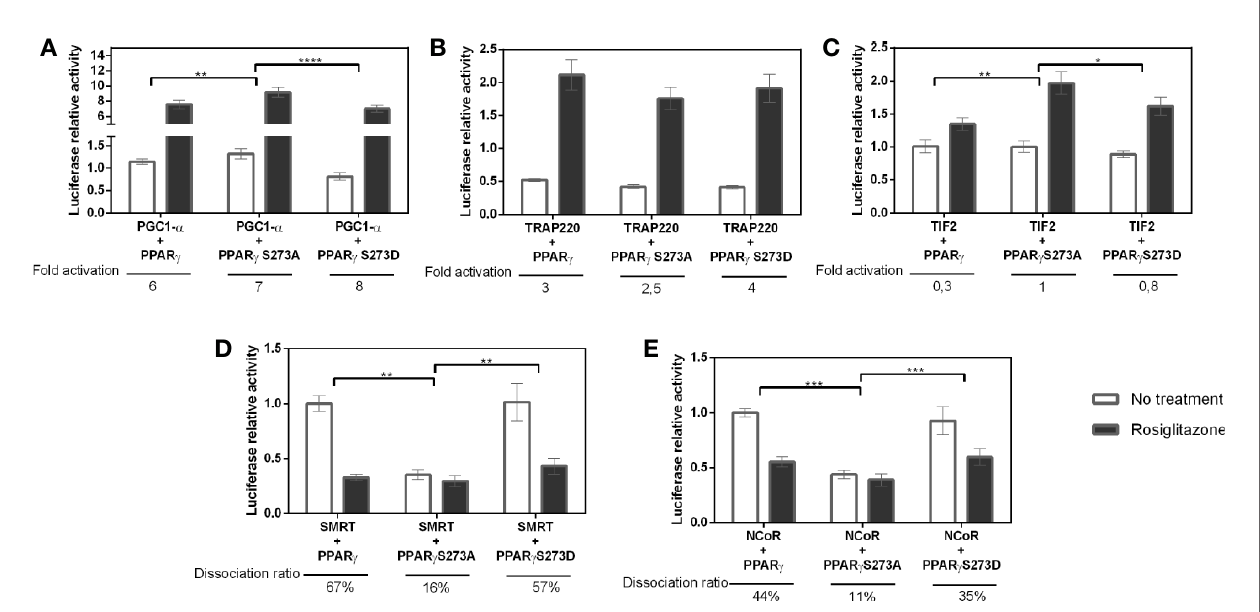
FIGURE 3 | Interaction between PPAR g and coregulators in different phosphorylation states. Interaction measured by mammalian two-hybrid assays were performed in COS-7 cells for (A) PGC1- a , (B) TRAP-220, and (C) TIF-2 coactivators and 239T cells for (D) SMRT and (E) NCoR corepressors. Error bars, SEM. (n=15) Statistical analysis: two-way ANOVA. P values: p ≤ 0.05* p ≤ 0.01** p ≤ 0.001***; p ≤ 0.0001****. The coactivators PGC1- a and TIF2 presented increased interaction with PPAR g S273A mutant, while the corepressors presented decreased interaction with the same receptor